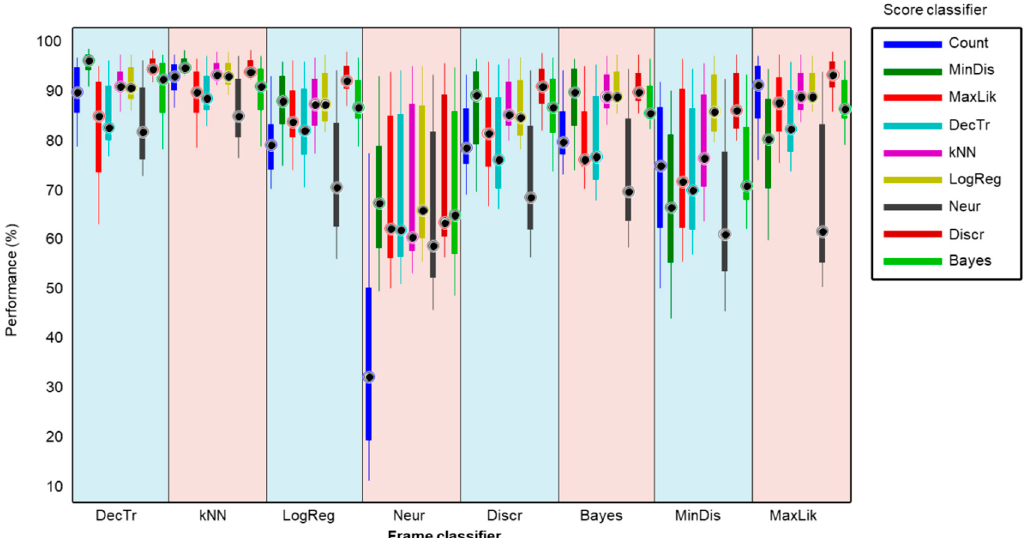
Figure 18. Boxplot of the performance metrics for the different score-series classifiers operating on the results obtained by every frame classifier.